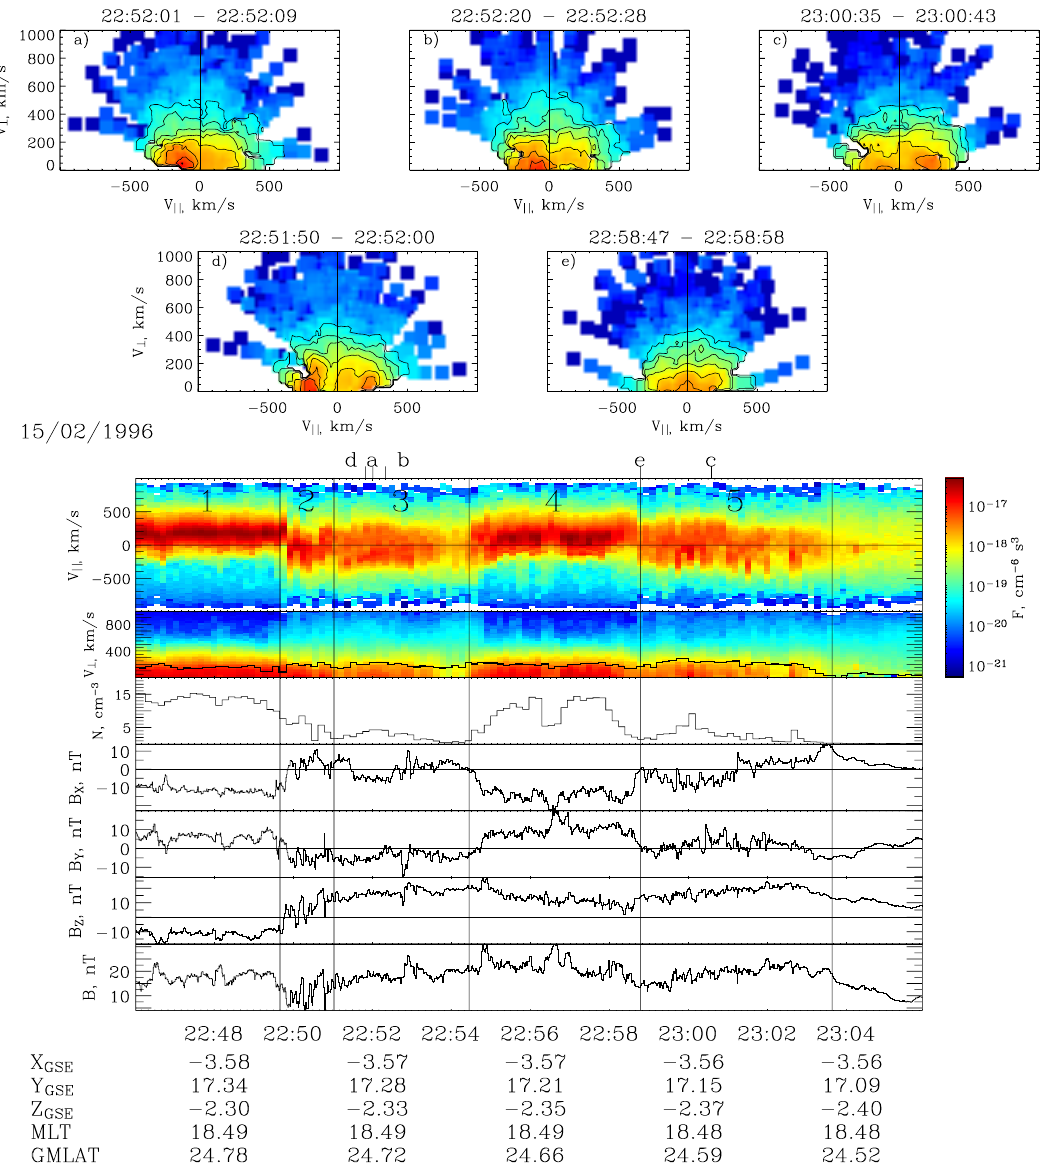
Fig. 7. Representative ion velocity distributions are given within the LLBL near the magnetopause on 15 February, 1996 (the same time interval as in Fig. 2). Two color-coded V k and V ⊥ velocity-time spectrograms show the phase space density integrated over perpendicular velocity (upper spectrogram) and the phase space density integrated over parallel velocity (lower spectrogram), after the velocity component transverse to the local magnetic field direction was subtracted. This transverse plasma velocity component is superimposed on the lower spectrogram (black line). Ion number density is shown on the bottom. Lettered lines above the spectrograms show locations where respective V k − V ⊥ velocity distributions were measured. GSE coordinates of the spacecraft, magnetic local time, and geomagnetic latitude are shown on the bottom. Time interval for each spectrogram is indicated on the top. See text for a more detailed